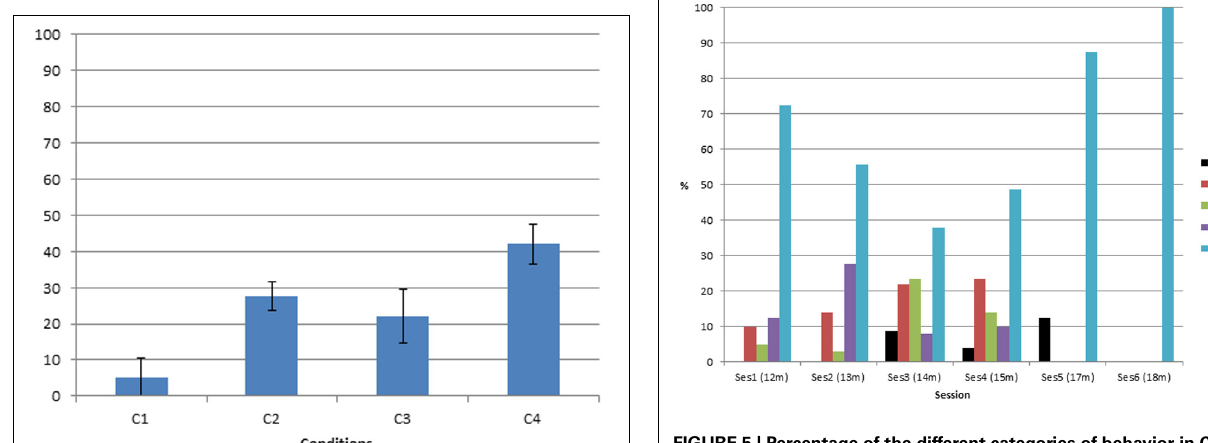
FIGURE 5 | Percentage of the different categories of behavior in C2 as a function of session. (NT, refusal; T, interested in toy only; R, interested in rake only; T + R, interested in connection between rake and toy but not for retrieval; S1 + S2, partial or total success at toy